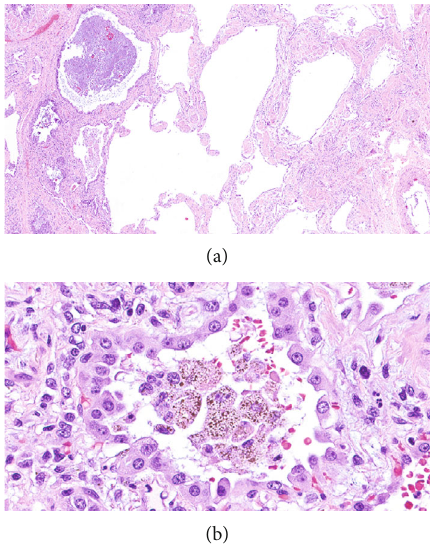
Figure 2: Histologic sections of the explanted (native) lungs show (a) fi brosing interstitial pneumonia with airspace enlargement (hematoxylin-eosin, original magni fi cation 30x) and (b) alveolar hemorrhage with hemosiderin-laden macrophages and reactive type 2 cells (hematoxylin-eosin, original magni fi cation